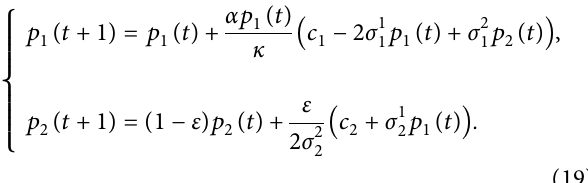
with respect to κ 1